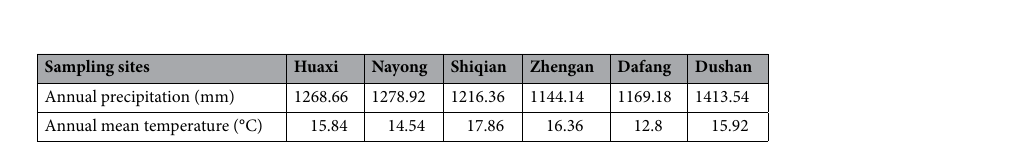
Table 1. Annual precipitation and annual mean temperature of sampling sites (data in 2014–2018).